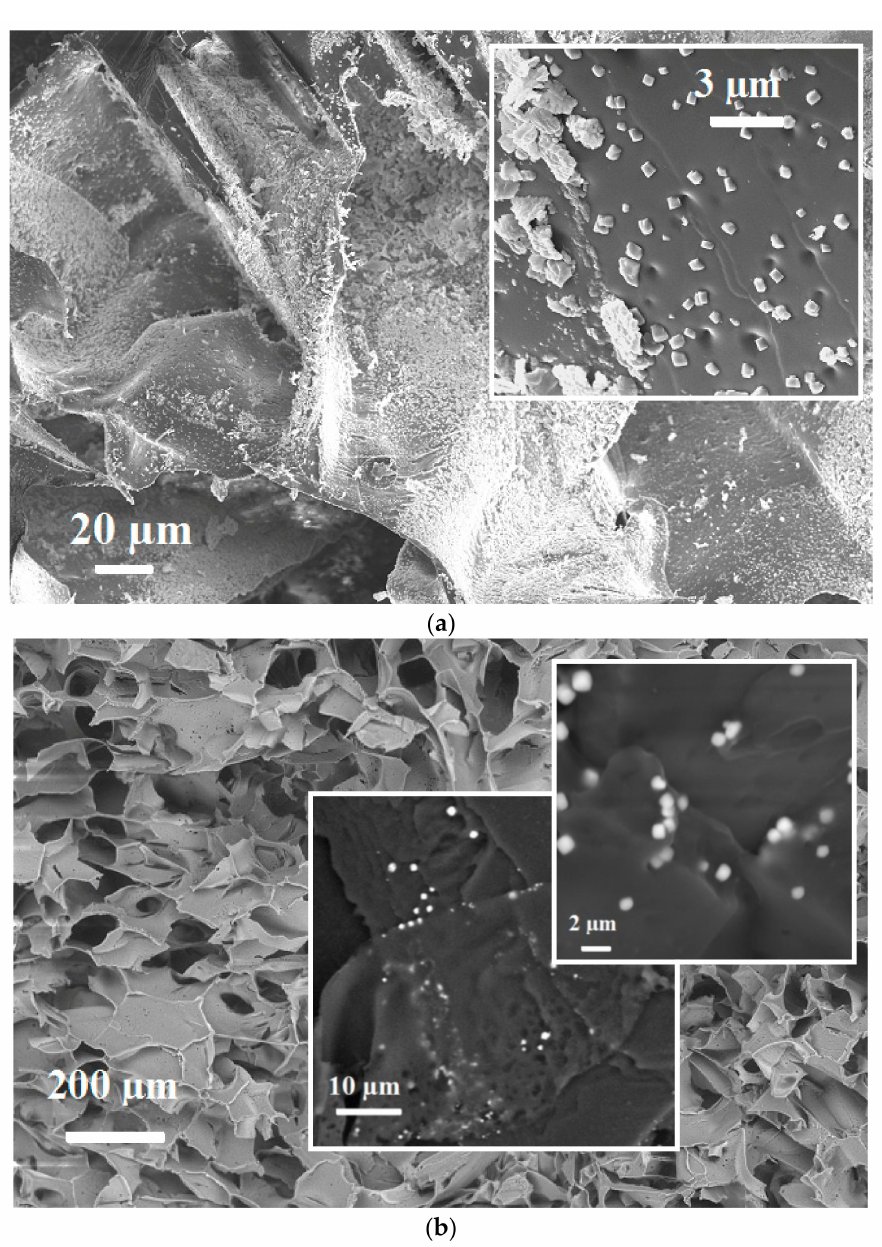
Figure 4. SEM images of the composite PEI/ZnFC cryogel fabricated via Method I ( a ) and Method II, upper part of the monolith ( b